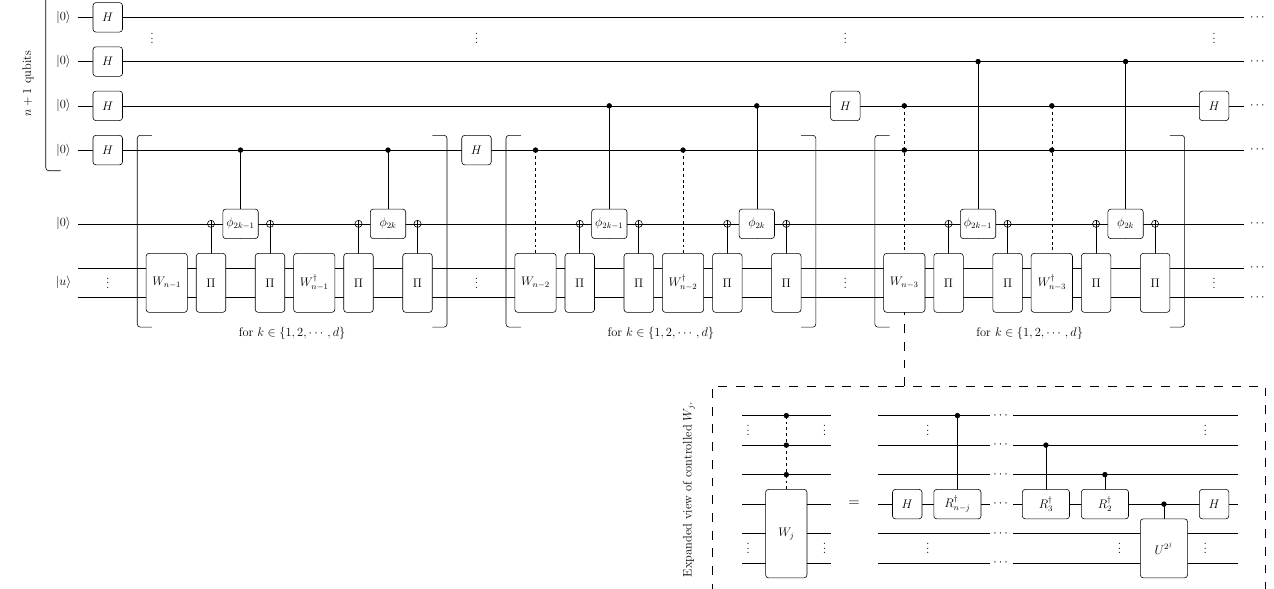
FIG. 12. A quantum circuit for performing phase estimation using the QSVT, following Algorithm 3. The dotted controlled opera- tors, denoted by W j at step j , represent a composite gadget (unwrapped in the inset block) that depends on the states of ( n − j − 2 ) controlling qubits above it. Here, controlled- φ j gates represent controlled- Z rotations by angle φ j . Additionally, this figure depicts only the even- d case of Theorem 4. This circuit terminates by measuring all auxiliary qubits in the computational basis. Also depicted is an expanded view of a subroutine in the circuit depicted for phase estimation. Note that the W j operator is the unitary that block encodes A j , as depicted in Fig. 10. Note also that each R (cid:21) operator is defined as in Eq. (73). The controlled R (cid:21) operations serve to adaptively zero out the currently estimated phase to the ( n − j − 2 ) th